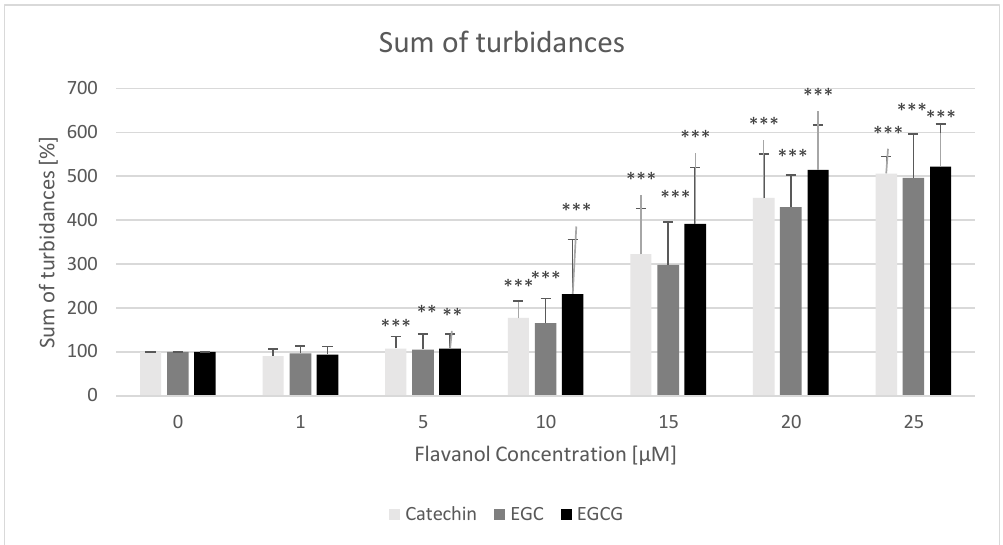
Figure 6. Effect of monomeric flavanols on the hemolysis of erythrocytes estimated from the sum of turbidance values during 120-min measurements (every 2 min). * p < 0.05, ** p < 0.01, *** p < 0.001 (with respect to control). Values for control samples were assumed as 100%.